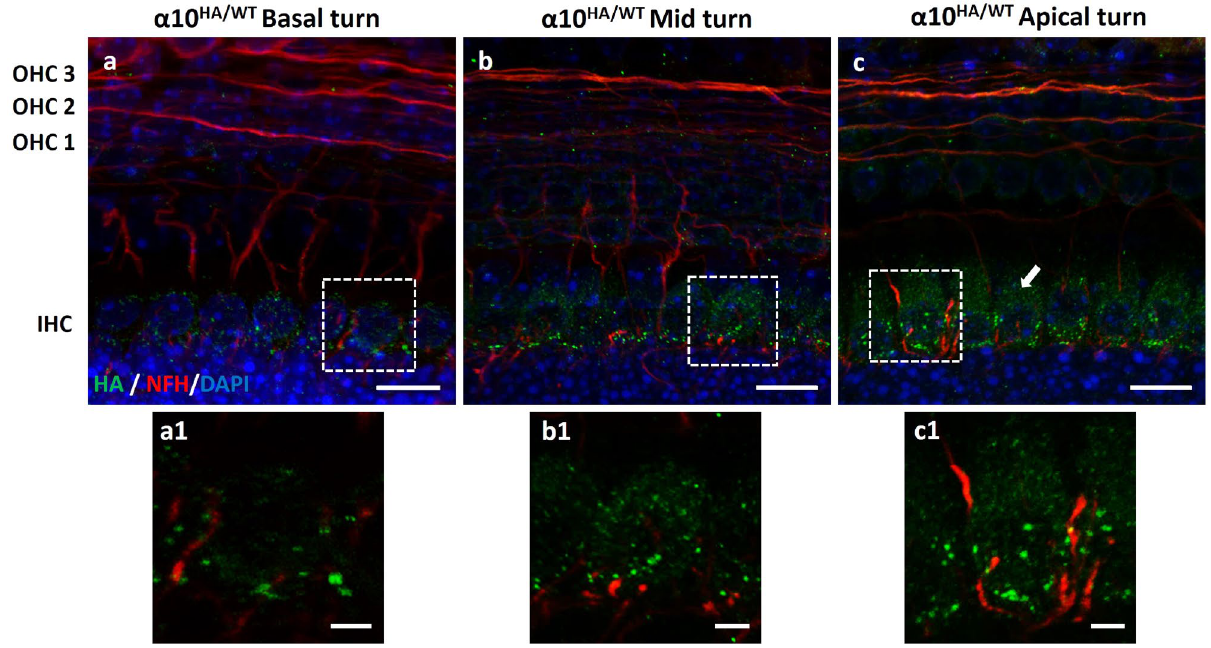
Figure 7. Expression of α10HA subunit in the developing cochlear sensory epithelium (P7–P8). The distribution of α10HA protein along the cochlea reflected that of its analogous α9HA subunit, suggesting a close structural and functional association ( a – c ). Similarly, α10HA protein immunopuncta were small, abundant, and arrayed around IHCs synaptic pole. Adjunct images ( a1 – c1 ) are a magnification of IHC synaptic pole detailing the immunolabeling of α10HA subunit surface membrane proteins. Diffuse cytosolic labeling in IHCs is indicated by arrow ( c , c1 ). Nuclei are visualized by DAPI staining (blue). Scale Bar: ( a – c ) 10 µm, ( a1 – c1 ) 2.5 µm. (α10 HA/WT N =